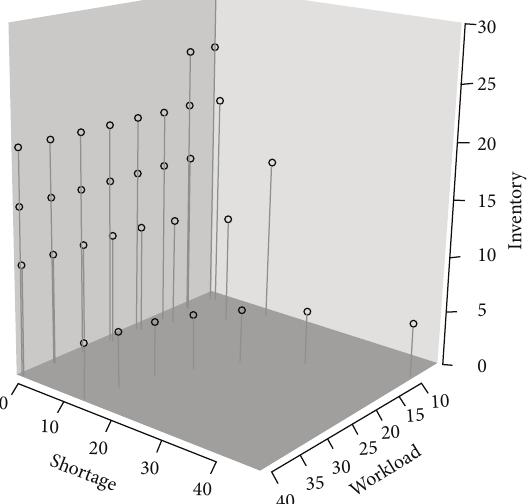
Figure 6: Scatterplot of Item 4 nondominated solutions from successive approximation.